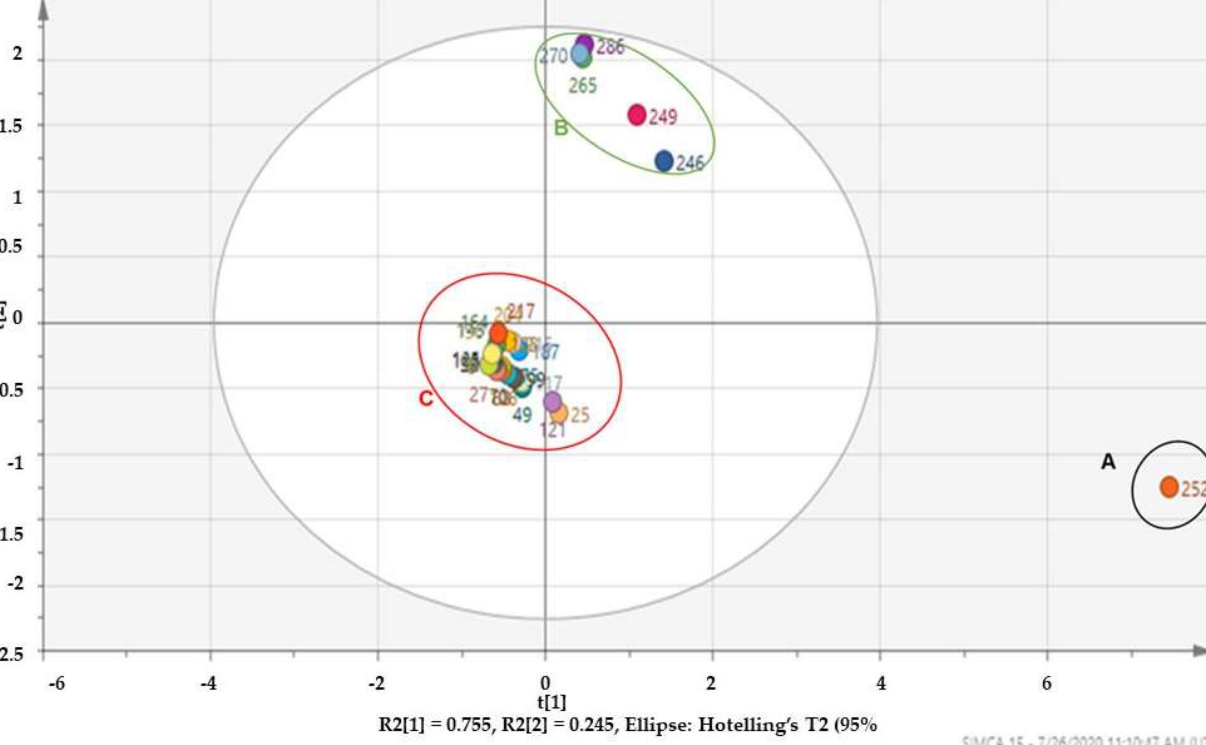
Figure 4. PCA score plot indicating two well-defined clusters with an outlier observation 252 of the volatile compounds in the hexane extract of MOS oils.